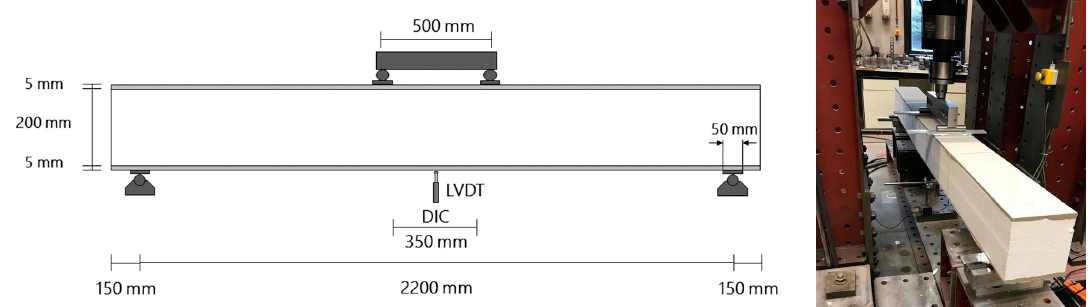
Figure 6. Four-point bending test set-up.